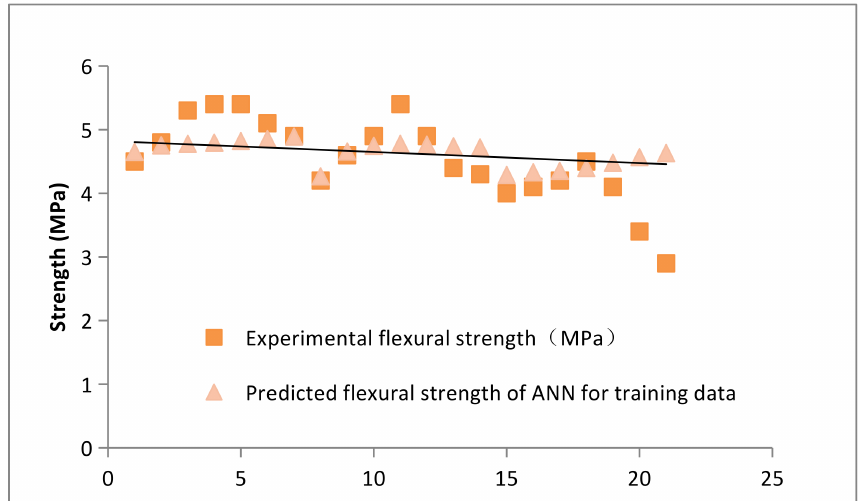
Figure 9. Tested and predicted flexural strength of ANN for training data.